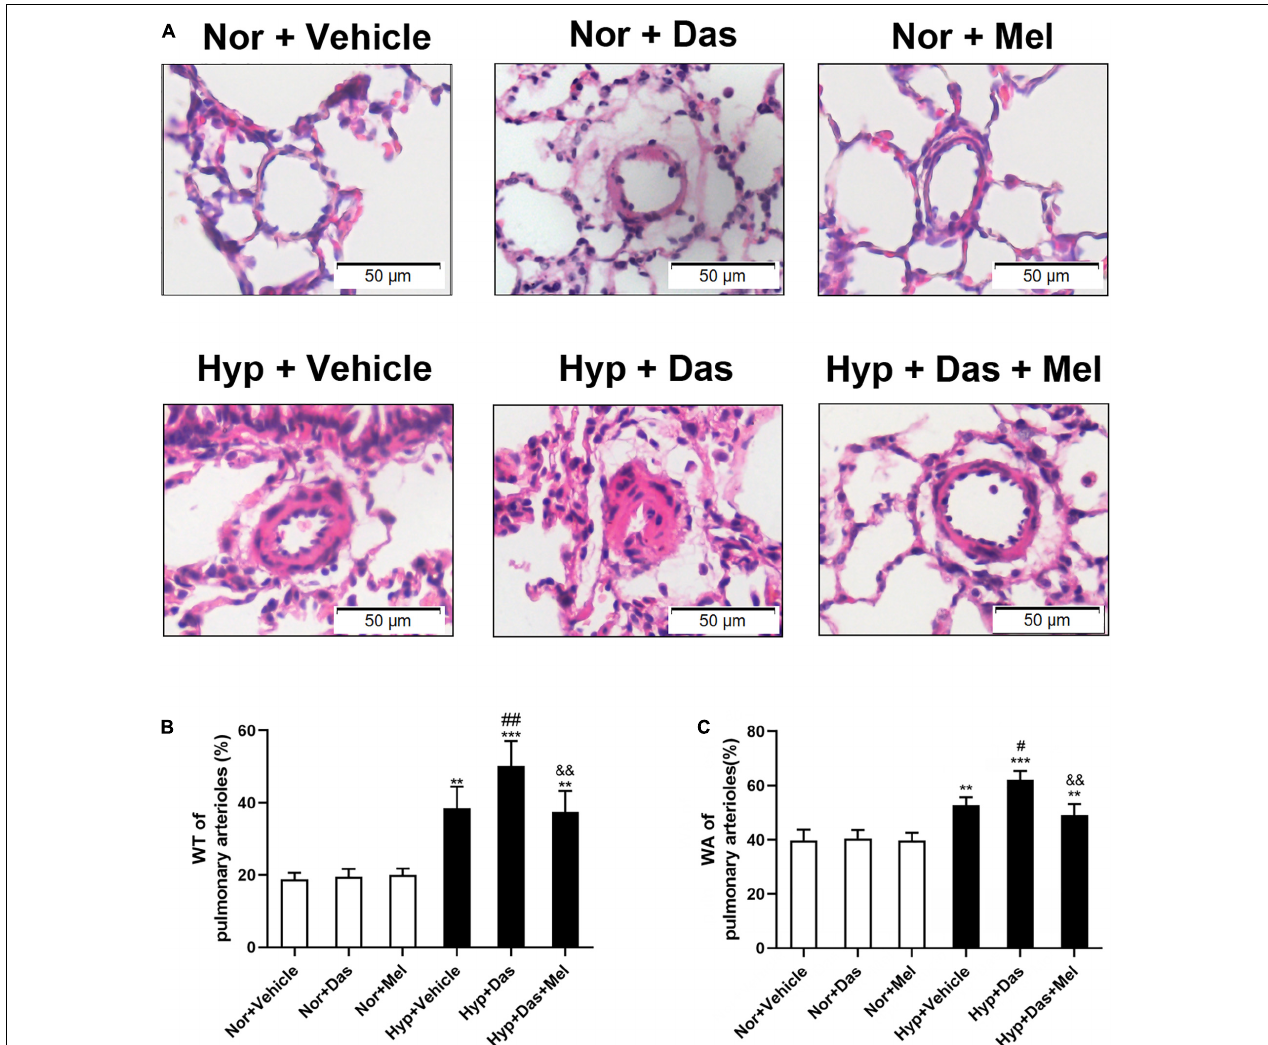
FIGURE 2 | Melatonin attenuates vascular remodeling induced by dasatinib under hypoxia. Hematoxylin and eosin (HE) staining of pulmonary arterioles (original magnification × 20, scale bars: 50 µ m.) (A) . Percentage of medial wall thickness (WT%) of pulmonary arterioles (B) . Percentage of medial wall area (WA%) of pulmonary arterioles (C) . Values are means ± SEM, ***P < 0.001, **P < 0.01 compared with Nor + Vehicle group. ## P < 0.01, # P < 0.05 compared with Hyp + Vehicle group. && P < 0.01 compared with Hyp + Das group ( n =